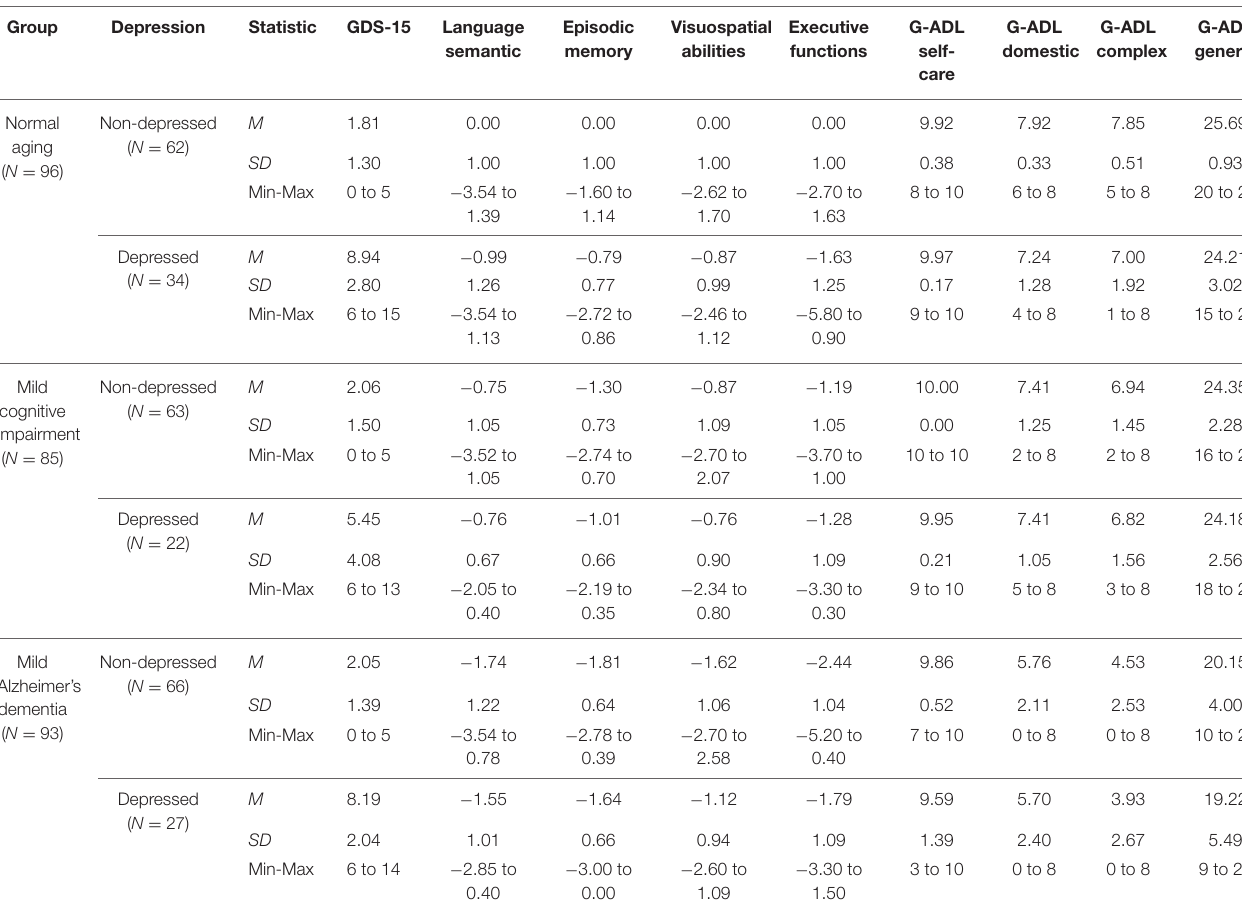
G-ADL G-ADL G-ADL Episodic Visuospatial Executive G-ADL domestic complex general semantic memory abilities functions self- care